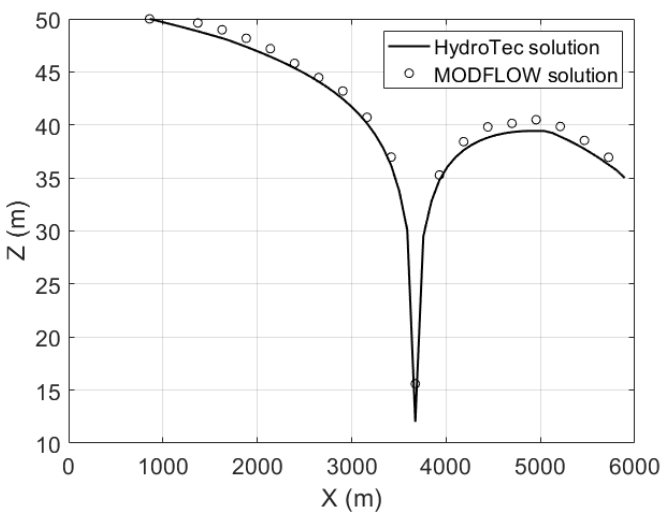
Figure 13. Comparison between the water table profile (parallel to X-axis and crossing the well position) simulated with the adaptive MHFEM approximation and the post-processed FDM approxi- mation for the three-dimensional problem. The maximum difference occurs at the well due to the coarse vertical discretization of the FDM fixed mesh.